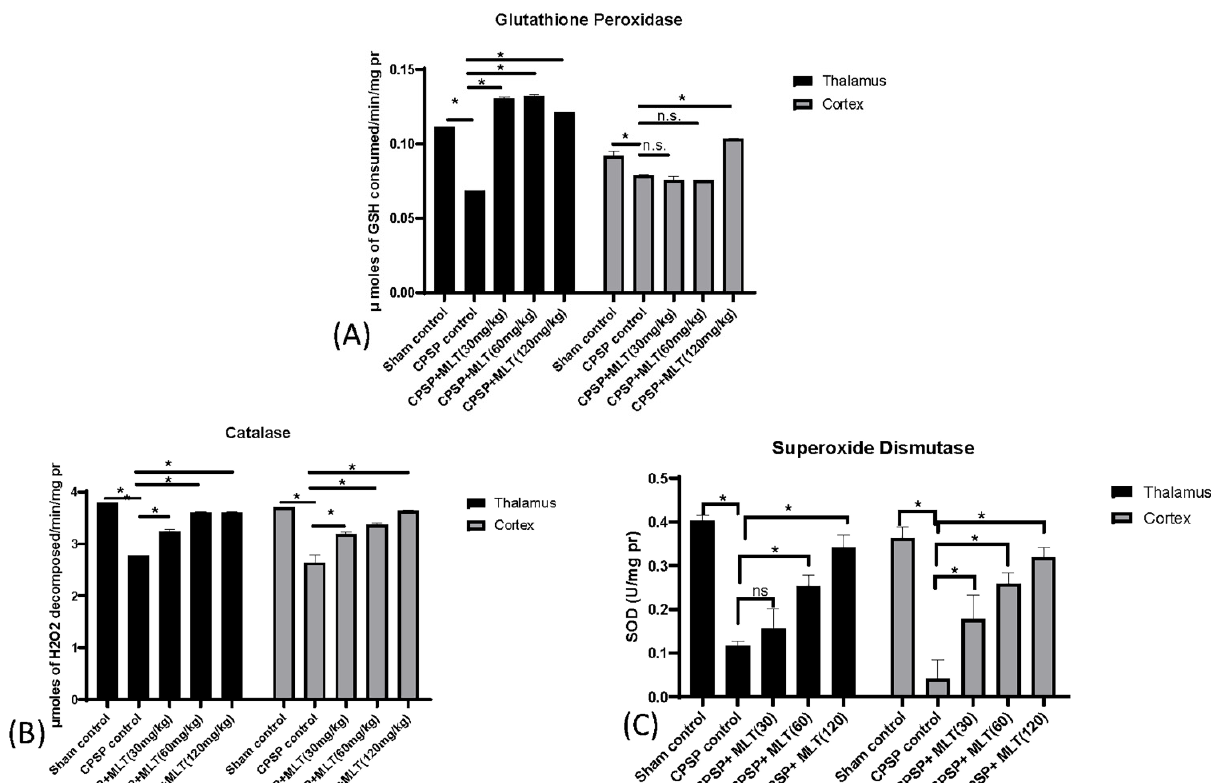
Figure 4. Effect of CPSP and melatonin on ETC chain enzymes A, including ( A ) gluthathione peroxidase (n = 4, per group), ( B ) catalase (n = 4, per group), and ( C ) superoxidase dismutase (n = 5, per group) levels in the thalamus and the cortex after two weeks of melatonin administration. Data expressed as mean ± SD; * p < 0.005 as compared with CPSP.